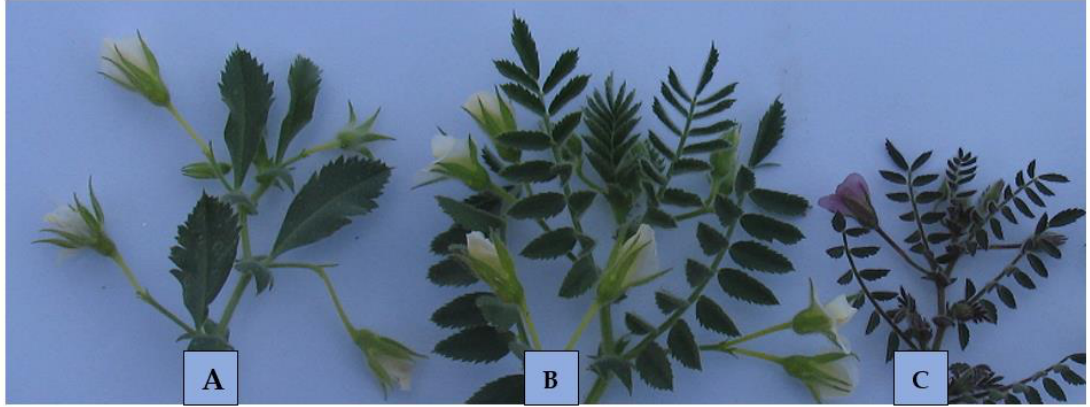
Figure 1. The leafminer-susceptible check Sierra ( A ), parents used in interspecific crosses between C. arietinum (CA 2969) ( B ) and C. reticulatum (AWC 602) ( C ).